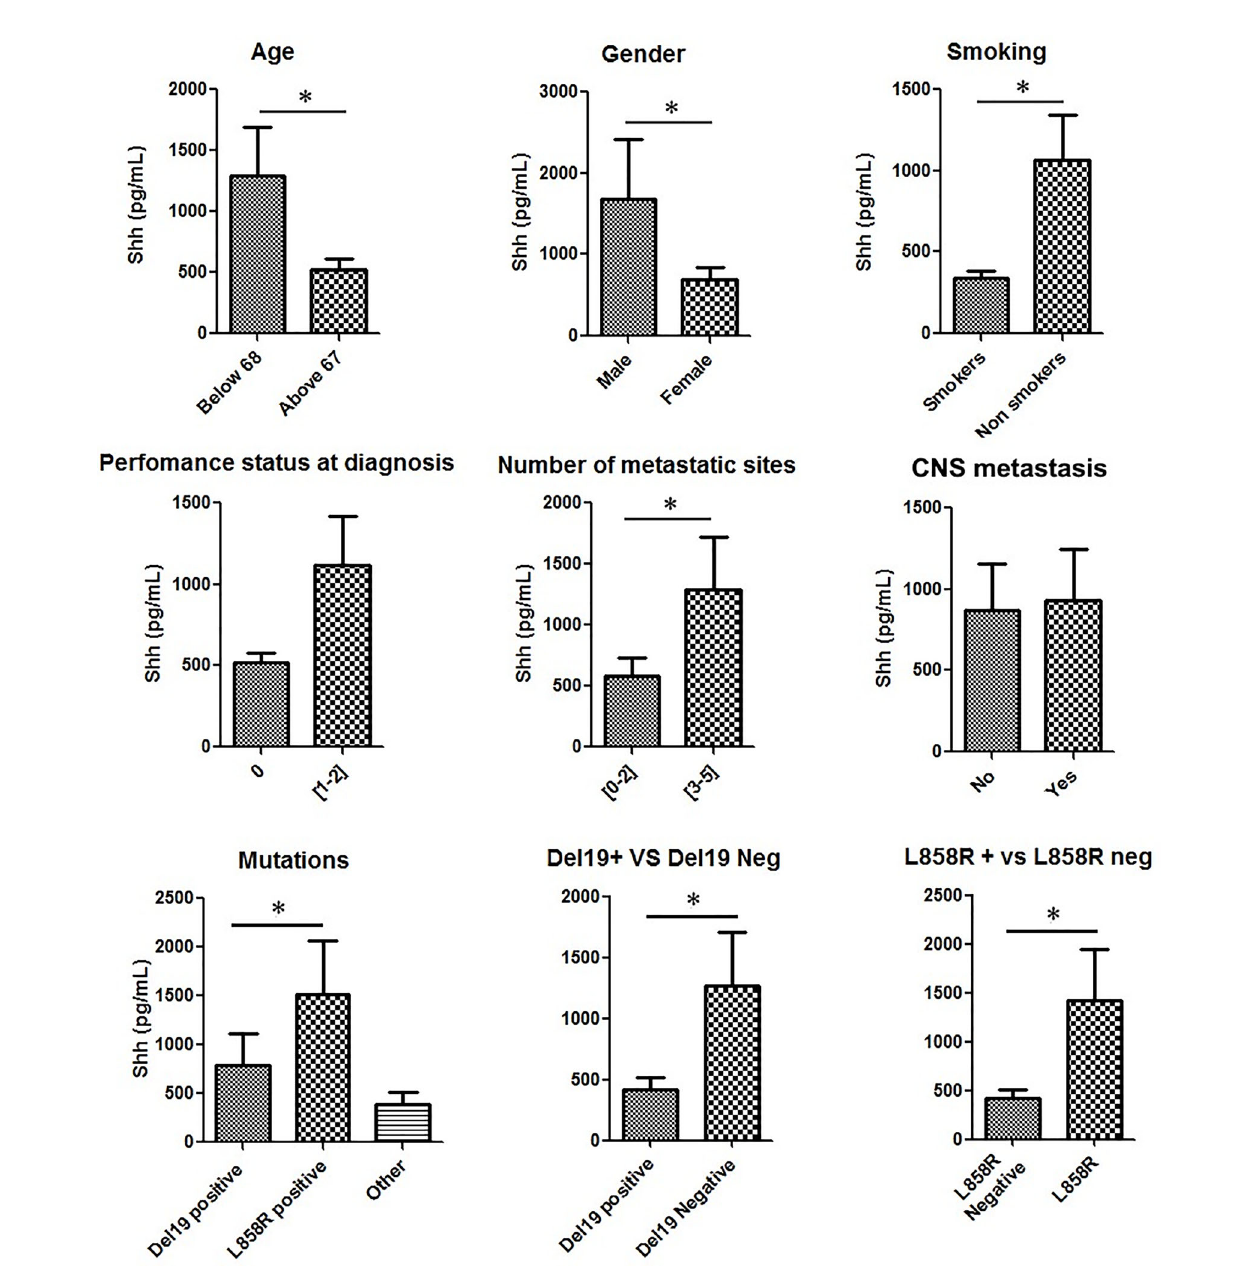
FIGURE 2 | Shh concentrations in plasma from patients at diagnosis according to patients ’ characteristics: Patient samples analyzed for Shh expression were classi fi ed according to age, gender, smoking status, performance status at diagnosis, number of metastatic sites, central nervous system (CNS) metastasis, and EGFR mutation type. A Mann – Whitney test was used to analyze the differences between means. * p <